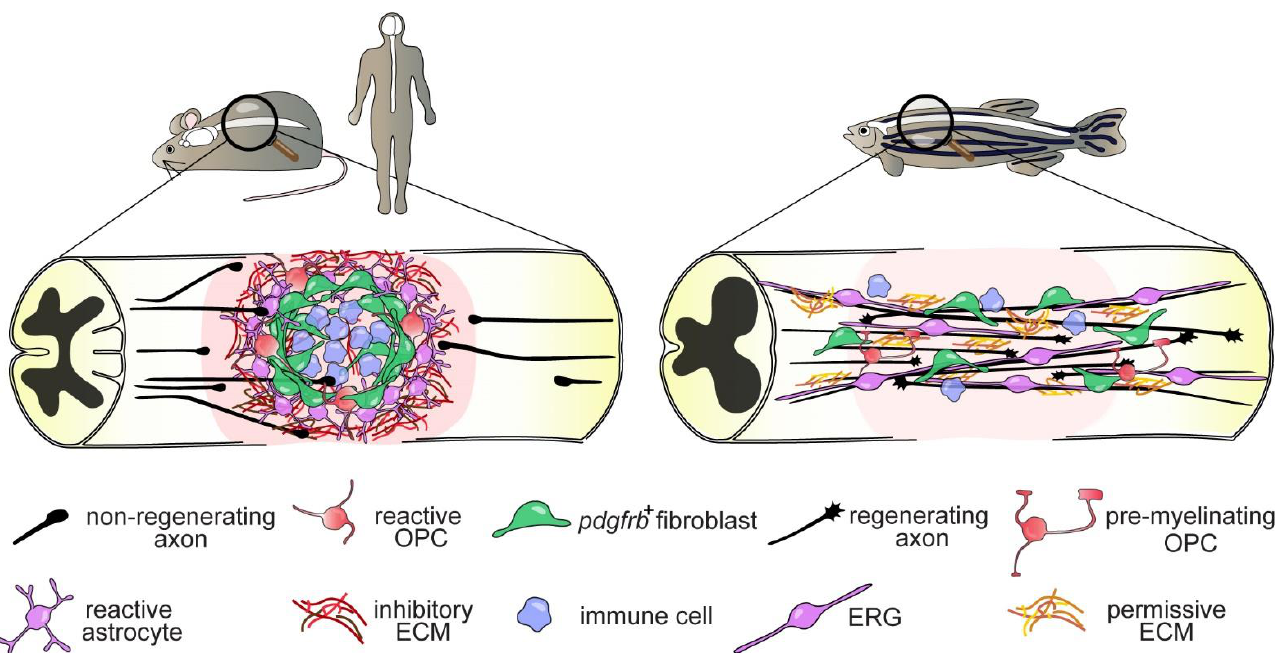
Figure 1. Differential regenerative capacities of the mammalian and zebrafish spinal cord. In mammals, a complex injury scar is formed by invading immune cells and pdgfrb + fibroblasts, as well as reactive OPCs and astrocytes, which constitutes a hostile environment to axon growth. Although these cell types respond in a similar manner to SCI in zebrafish, they do not contribute to the formation of an injury scar. Instead, reactive cells promote axonal regrowth (bridging) across the lesion site. Shown are major target cells underlying the different fate in either species. Abbreviations: OPC, oligodendrocyte progenitor cell; pdgfrb + , platelet-derived growth factor receptor β -positive; ECM, extracellular matrix; ERG, ependymo-radial glia.